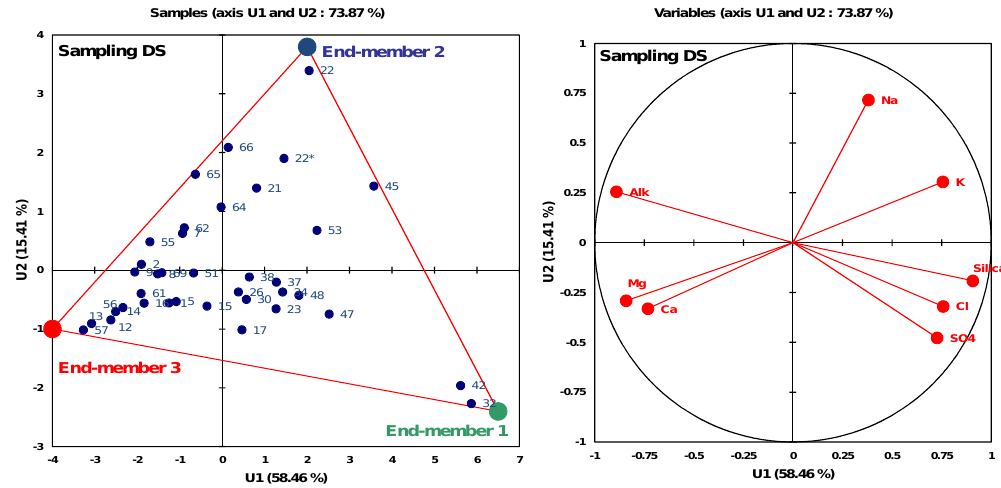
Fig. 7. Sample and variable distributions on the first factorial plan of the PCA 2 carried out on DS sampling.